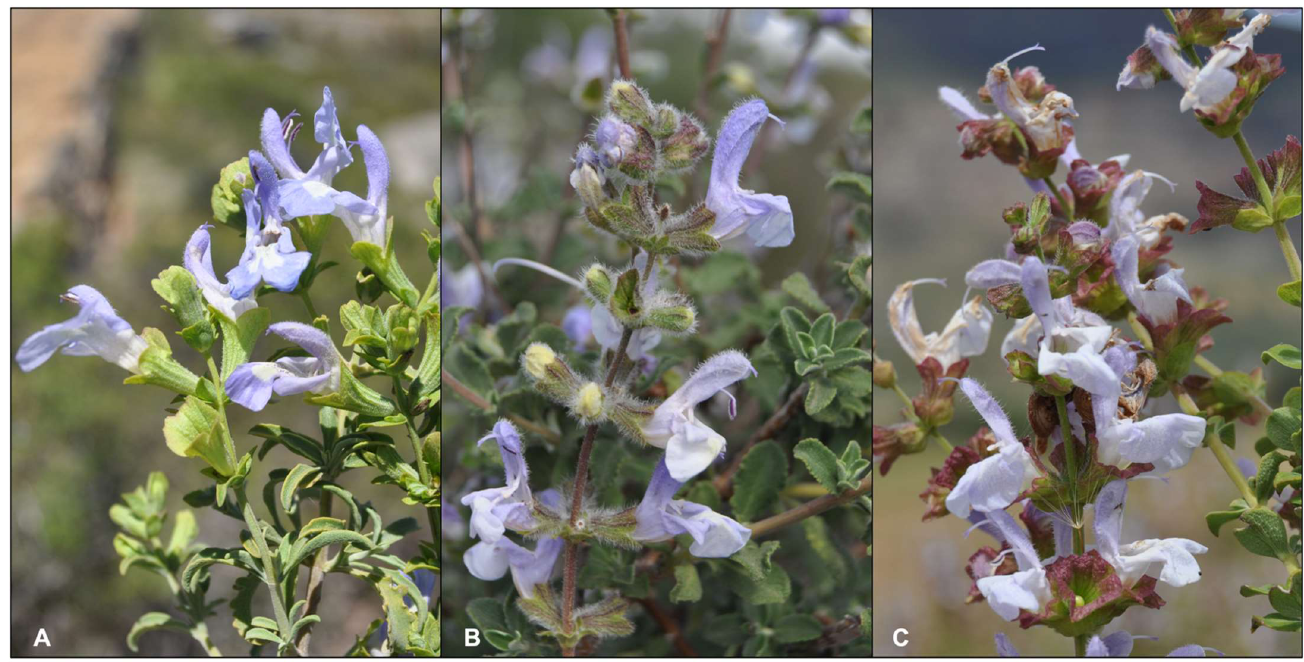
Figure 1. Three closely related, blue-flowered South African medicinal Salvia species. ( A ) Salvia dentata , ( B ) S. africana and ( C ) S. chamelaeagnea. All photographs taken by B.-E. Van Wyk.